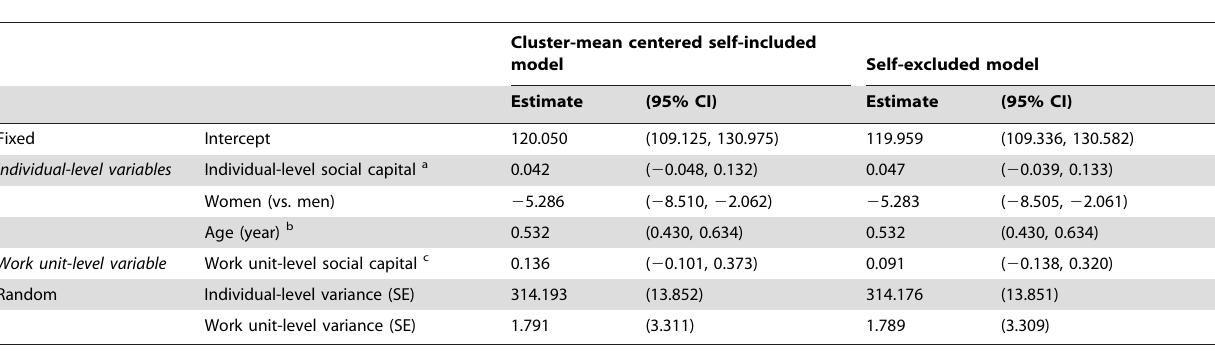
Table 5. Effects of individual-level and work unit-level social capital on systolic blood pressure of workers, Japan, 2009.